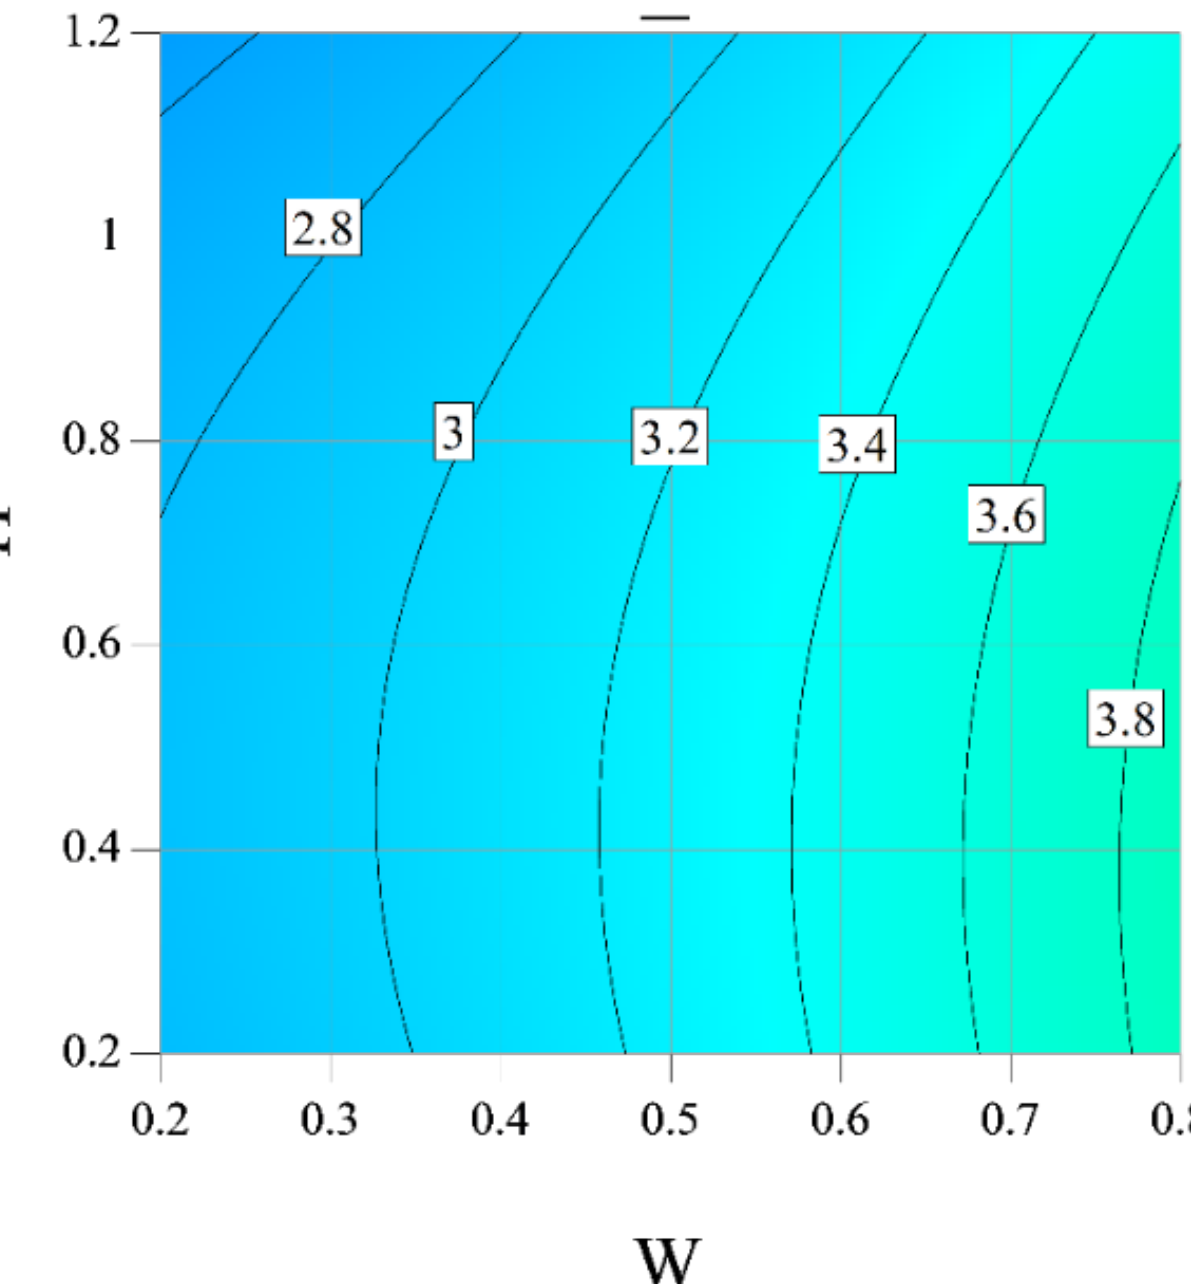
Figure A11. EGN for different blade heights and lengths when Ra = 10 5 , Ha = 30, and the volume fraction is 0.3%.